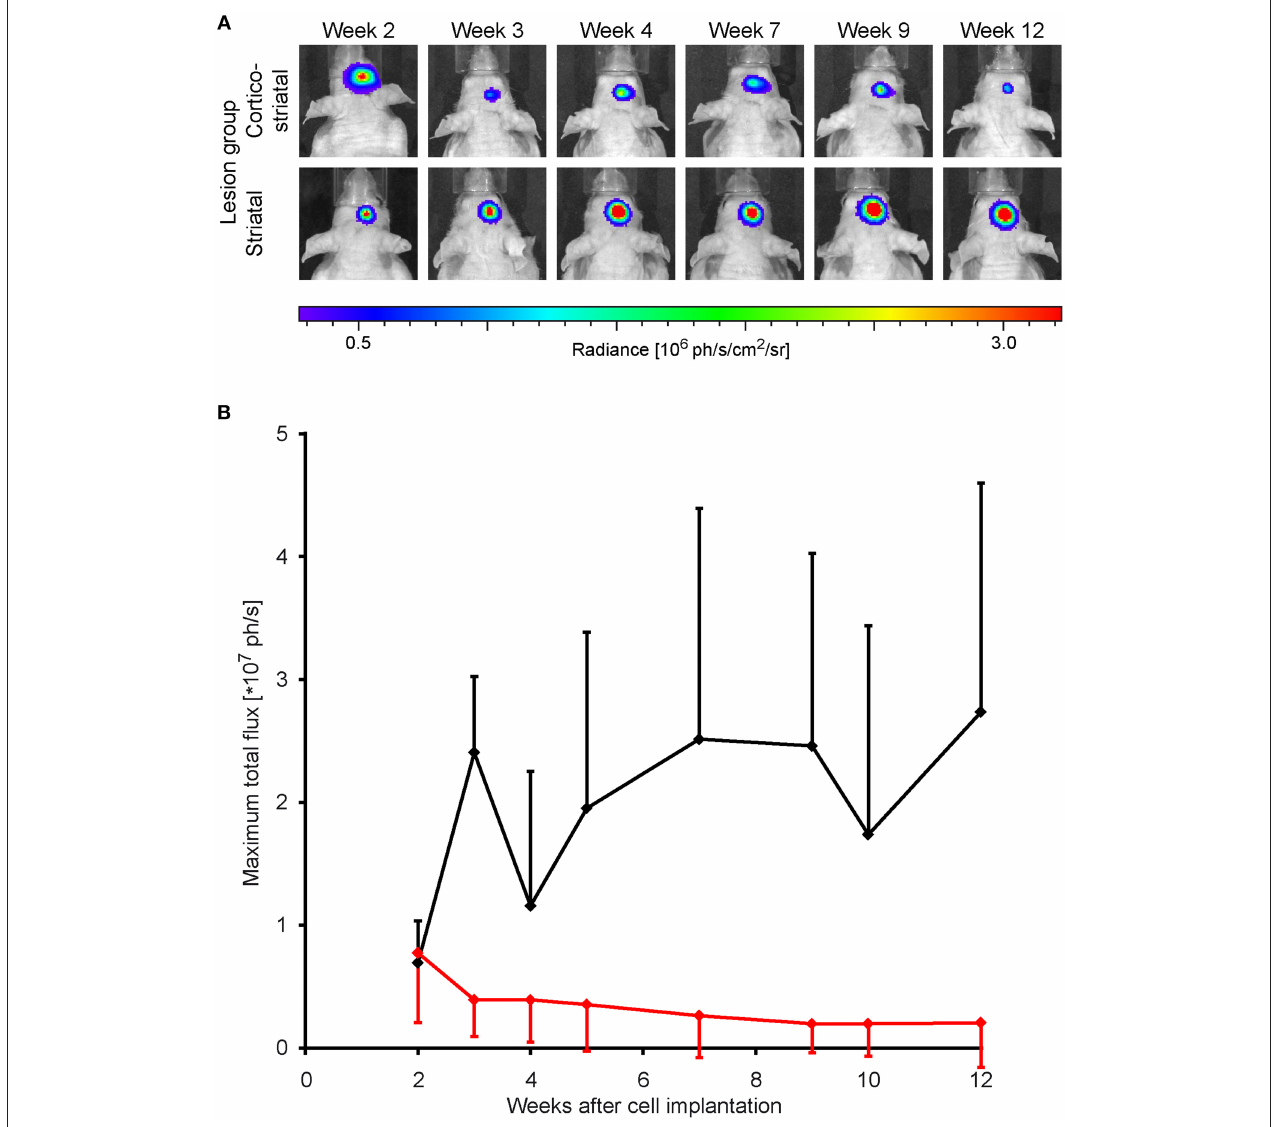
FIGURE 2 | Stem cell graft viability during 3 months after implantation. Bioluminescence imaging of the luciferase-expressing neural stem cells was recorded over 3 months every 1 or 2 weeks after implantation into the cortex of the ischemic hemisphere. (A) Representative animals of the cortico-striatal and striatal lesion group at various time points after implantation. The BLI intensity of the cortico-striatal lesion animal shows a continuous decrease over time, while the BLI intensity of the mouse with striatal lesion remains stable over the whole 3 months. (B) Quantitative analysis of BLI intensity of both lesion groups with in-group standard deviations: the striatal lesion group (black line) shows an overall stable BLI signal intensity on the pre-stroke level. The BLI signal intensity of the cortico-striatal group (red line) presents a rapid decrease with time, leveling off at ∼ 30% of the pre-stroke value. striatal group being less pronounced and showing a clear trend toward normalization ( Figure 3 , bottom right).